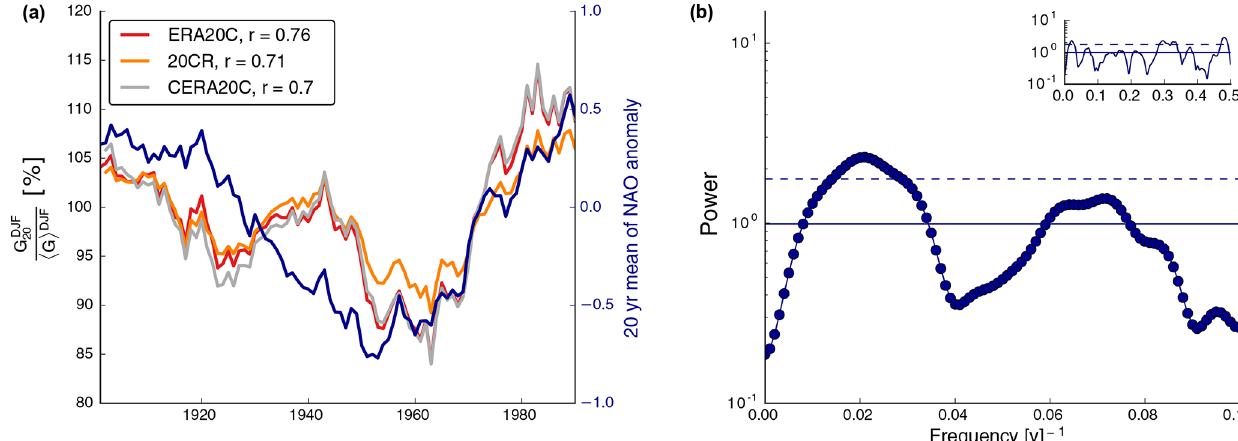
Figure 4. Relation between normalized lifetime winter generation and the winter North Atlantic Oscillation. Time series of wind power generation (in red, orange and gray) refer to the left y axis while the NAO time series (in blue) refers to the right y axis (a) . Pearson correlation coefficients, r , are calculated between the 20-year mean NAO anomaly and the 20-year mean DJF wind power generation. MTM spectrum of the winter NAO (bullets in b ), focusing on the low-frequency interval of the spectrum. Solid lines represent the fitted spectrum of an AR(1) process that is used for significance testing and the dashed lines correspond to the 90% confidence level (see Sect. 2 for details).